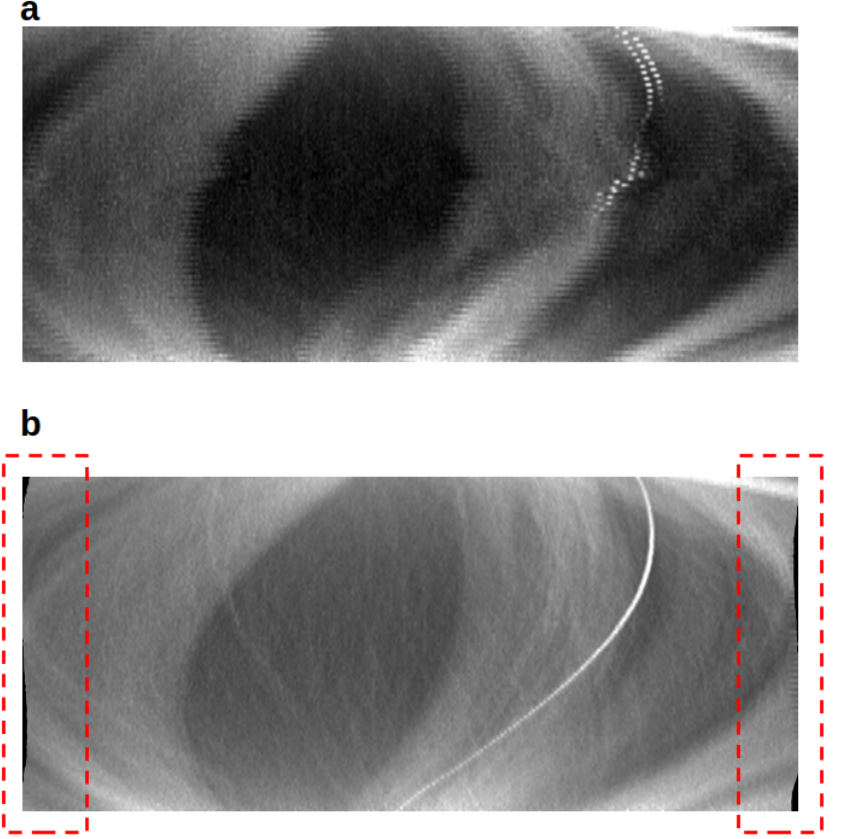
Figure 8. Alignment of a real nano-tomography dataset; raw data (panel ( a )) and their aligned version (panel ( b )), where a high-contrast feature effectively creates a recognisable sinogram. Note the effect of the shift, which inevitably creates zero-padded